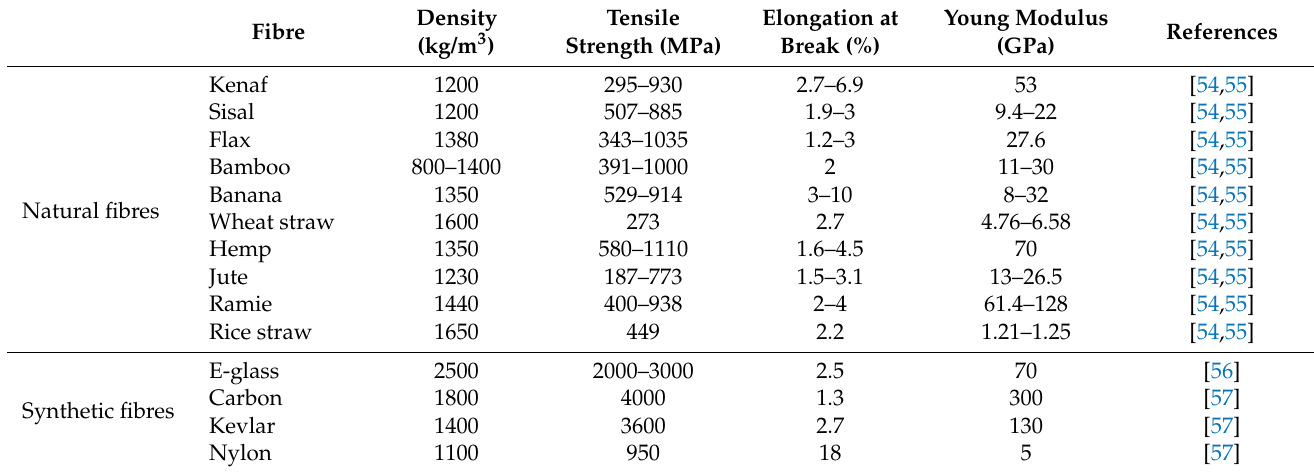
Table 1. Physicomechanical properties of some commonly used